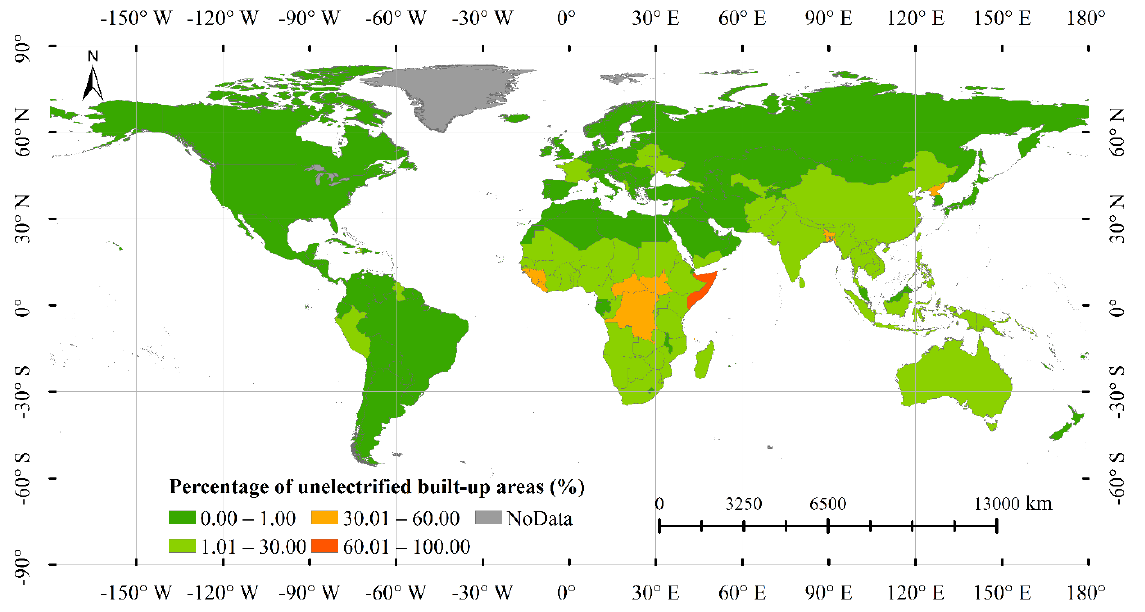
Figure 4. Distribution of the percentage of unelectrified built-up areas by country, 2014.